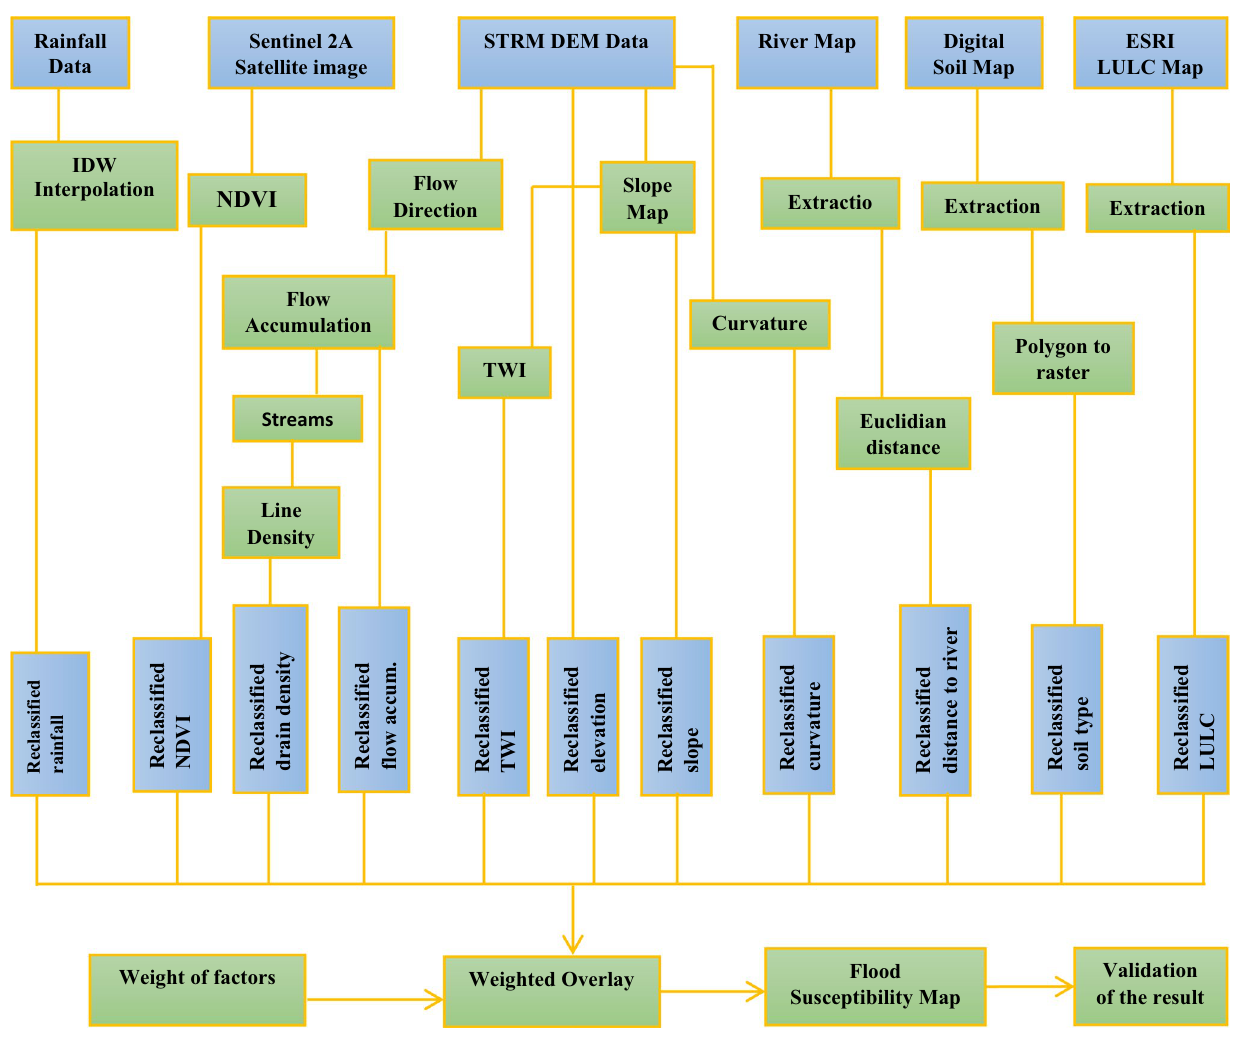
Fig. 2 Flowchart of the methods used to identify and map flood-prone